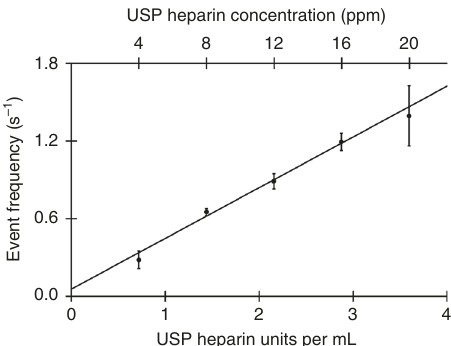
Fig. 4 Heparin calibration curve. Three trials were performed, with at least 500 events per run extracted from 900 s-long measurements in a ~9.3 nm pore at + 200 mV applied voltage difference after consecutive addition of 1 µ L aliquots to the headstage side of the same nanopore. Error bars are the standard deviation for the three trials